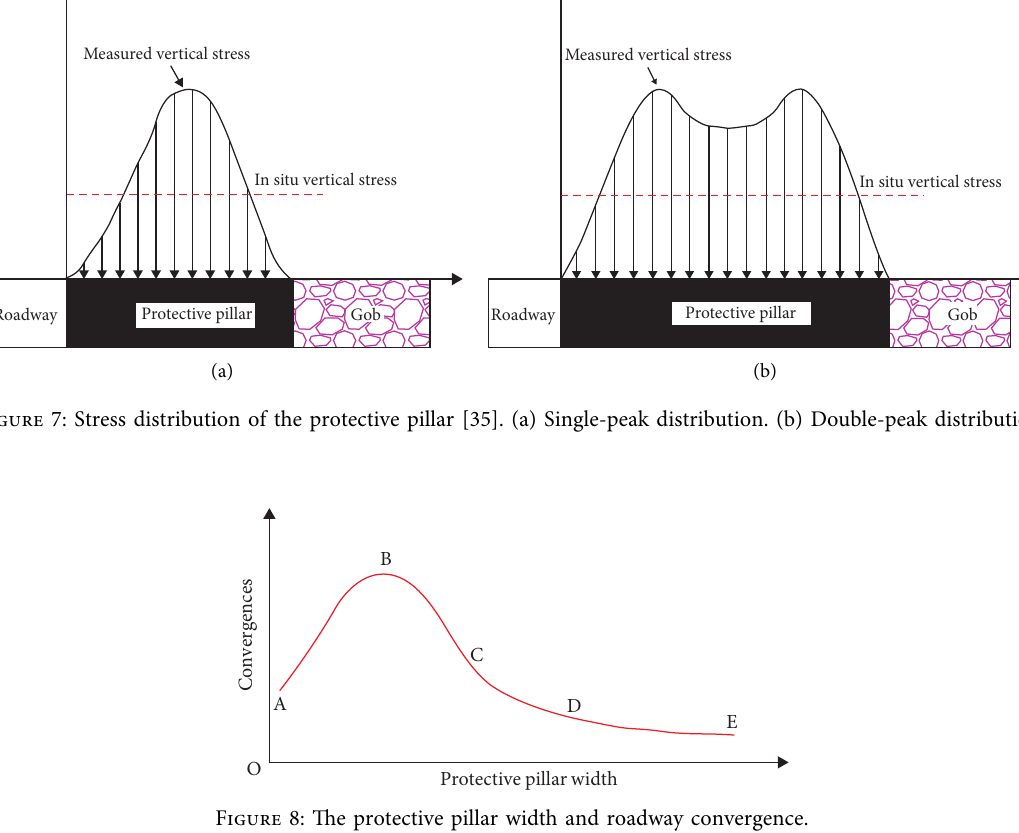
Figure 8: The protective pillar width and roadway